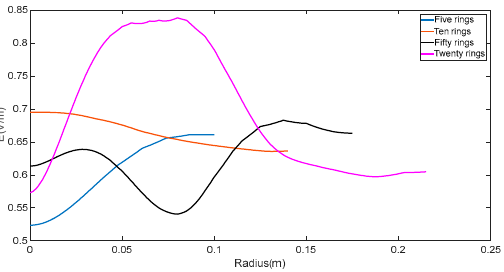
Figure 16. Radial profile of the electric field for a wet poplar sample with a 100% dielectric constant variation between growth rings. Dielectric constant values were used with 0% moisture content according to [27].